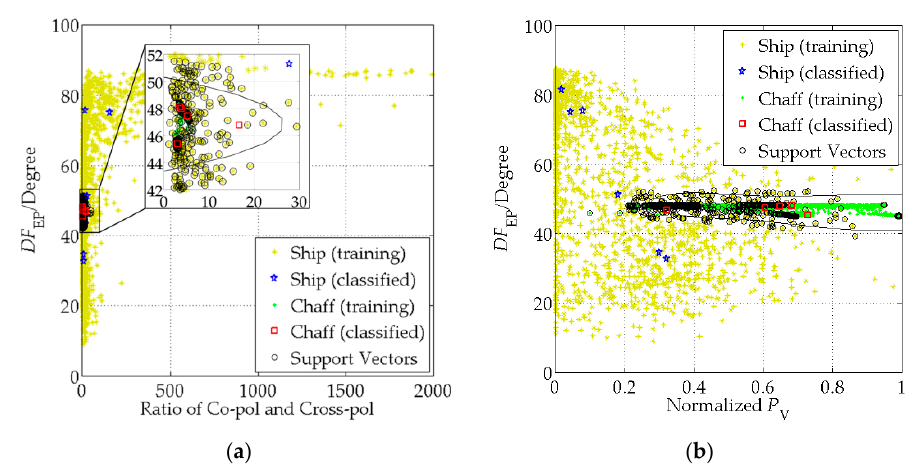
DF + EP DF , and SVM. ( b ) The EP DF , and EP